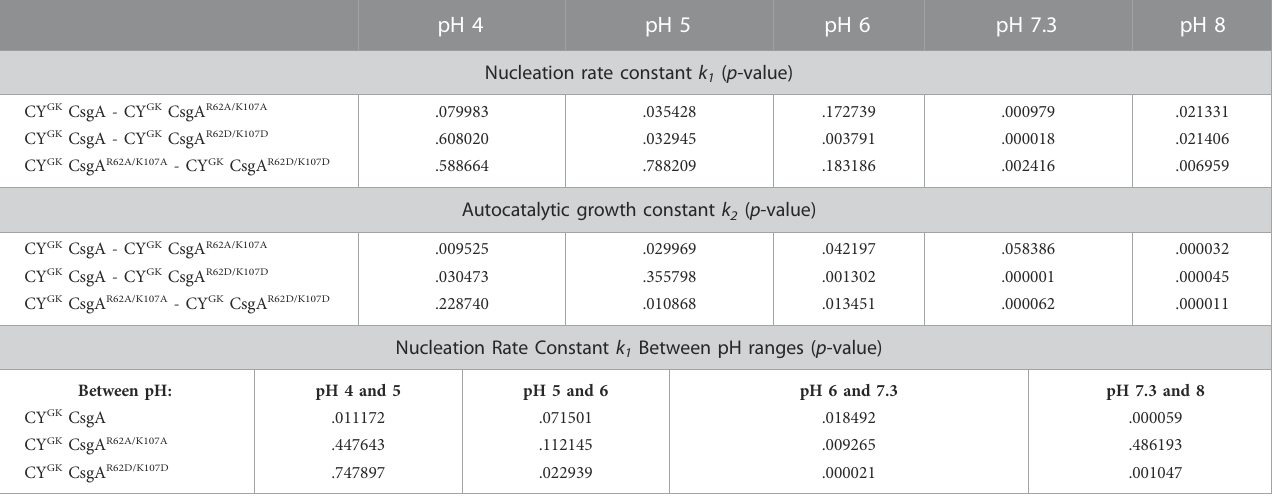
TABLE 1 T -test for Nucleation Rate Constants and Autocatalytic Growth Constants at Various